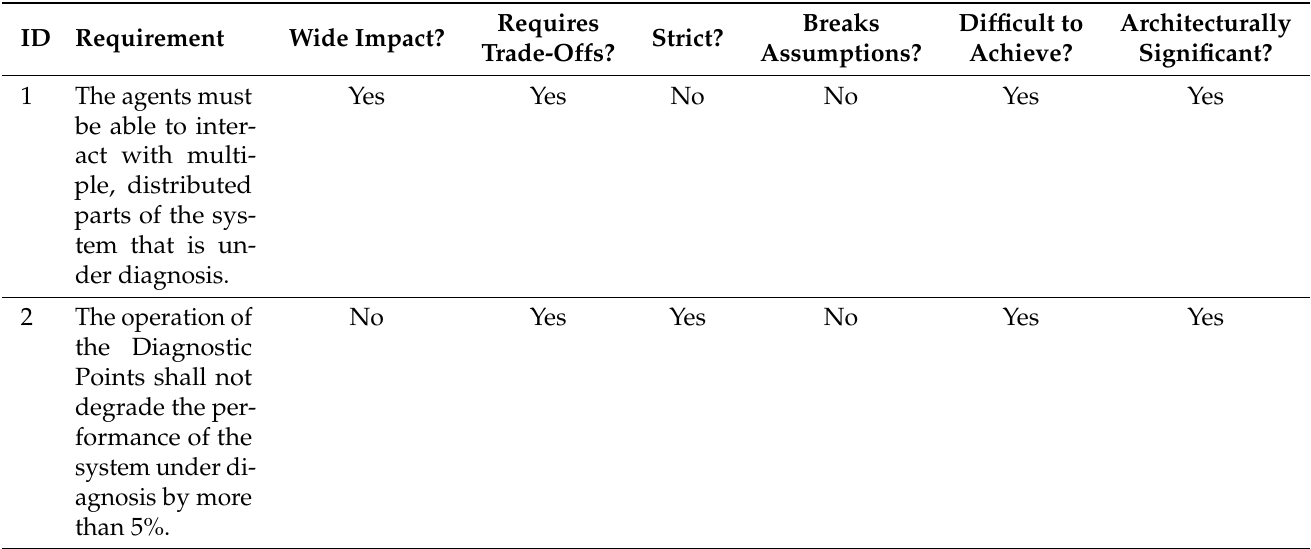
Table 1. Chen et al. criteria for being architecturally